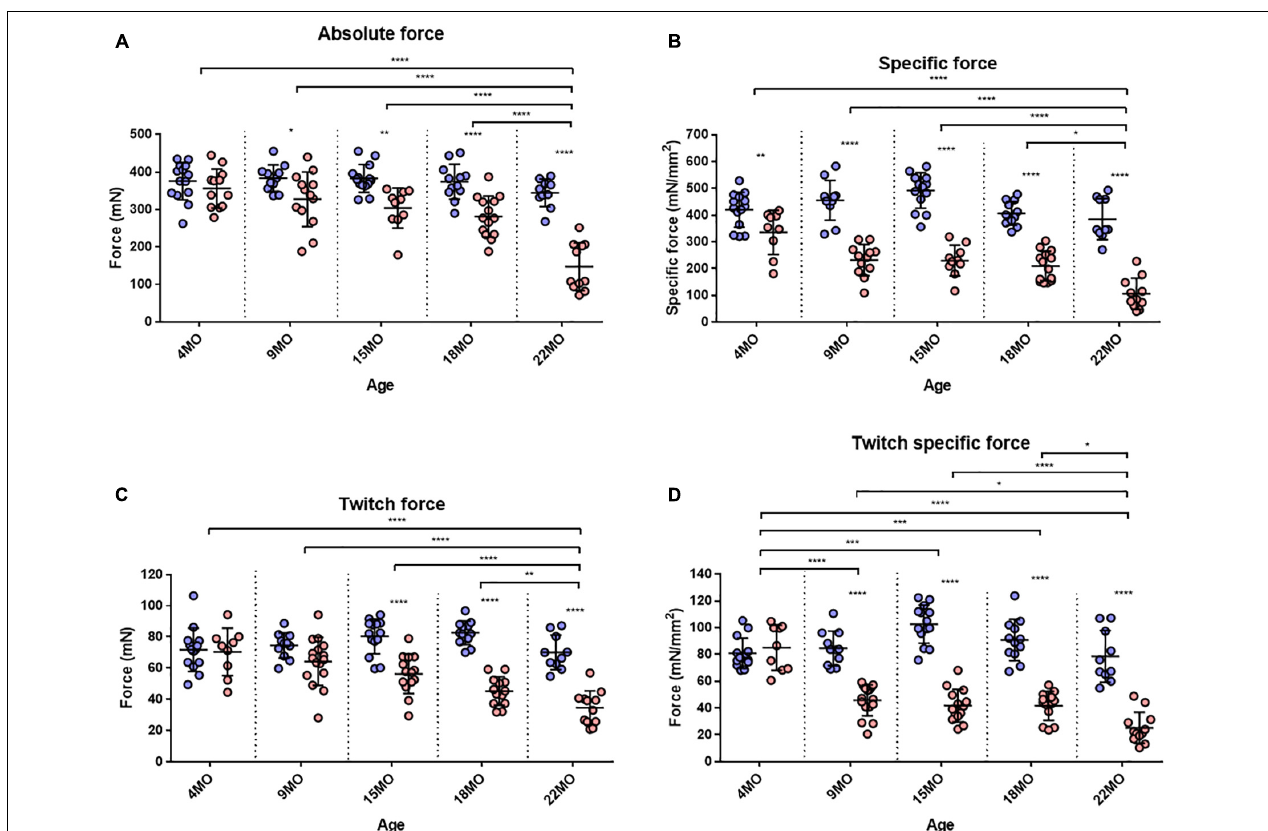
FIGURE 3 | Maximum tetanic and twitch force. (A) Interleaved scatterplot of the maximum absolute force generated by EDL muscles across 4-month ( n = 14 control; n = 12 mdx ), 9-month ( n = 11 control; n = 13 mdx ), 15-month ( n = 14 control; n = 10 mdx ), 18-month ( n = 12 control; n = 14 mdx ), and 22-month ( n = 10 control; n = 11 mdx ) age groups. (B) Interleaved scatterplot of the maximum specific force (force per physiological cross-sectional area) generated by EDL muscles across 4-month ( n = 14 control; n = 9 mdx ), 9-month ( n = 11 control; n = 12 mdx ), 15-month ( n = 14 control; n = 10 mdx ), 18-month ( n = 12 control; n = 14 mdx ), and 22-month ( n = 10 control; n = 11 mdx ) age groups. (C) Interleaved scatterplot of the twitch force generated by EDL muscles across 4-month ( n = 14 control; n = 9 mdx ), 9-month ( n = 11 control; n = 16 mdx ), 15-month ( n = 14 control; n = 14 mdx ), 18-month ( n = 12 control; n = 13 mdx ), and 22-month ( n = 10 control; n = 12 mdx ) age groups. (D) Interleaved scatterplot of the twitch specific force generated by EDL muscles across 4-month ( n = 14 control; n = 9 mdx ), 9-month ( n = 11 control; n = 16 mdx ), 15-month ( n = 14 control; n = 14 mdx ), 18-month ( n = 12 control; n = 13 mdx ), and 22-month ( n = 10 control; n = 12 mdx ) age groups. In each group the horizontal line indicates the mean value ± SD. Statistical differences between age groups are displayed above the graph, statistical differences displayed within graphs are differences between genotypes assessed by two-way ANOVA, post hoc analysis using Sidak’s multiple comparisons test. **** P < 0.0001, ***0.0001 < P < 0.001, **0.001 < P < 0.01, and *0.01 < P <